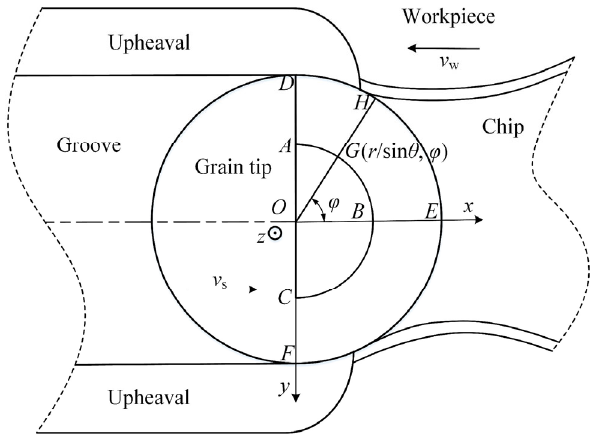
Fig. 2 Strain caused by grain tip (top view).